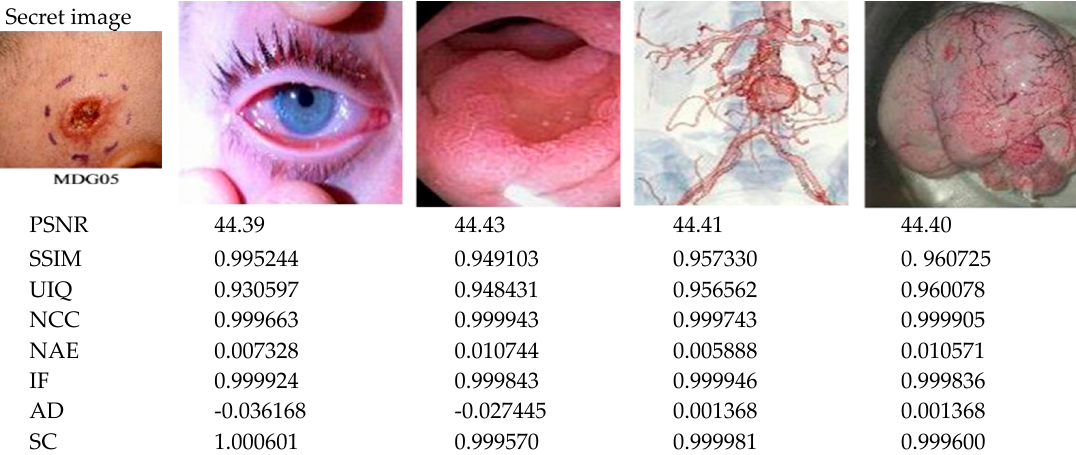
Figure 10. Performance analysis of the proposed protocol for colour medical images. Here, the secret medical image MDG05 is embedded onto all the remaining cover colour images (labelled MDG01 through MDG04 in Figure 3).